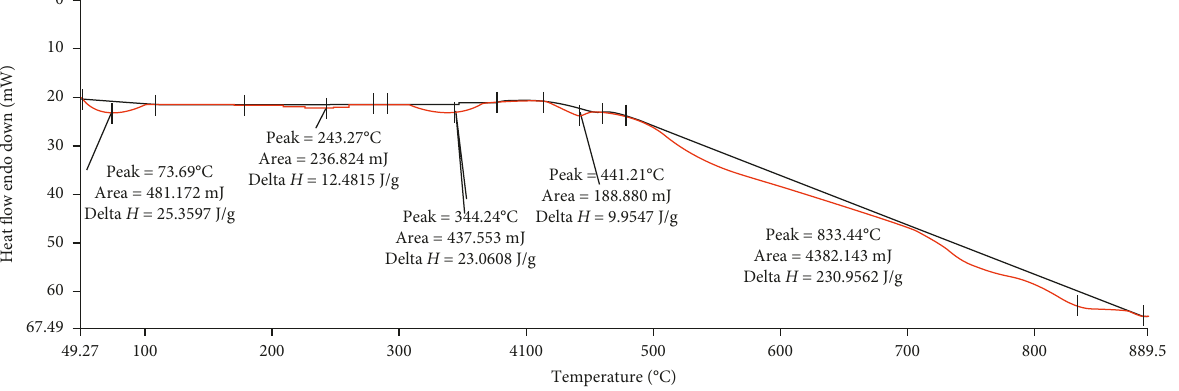
2 atmosphere (50mL/min); heating rate of 10